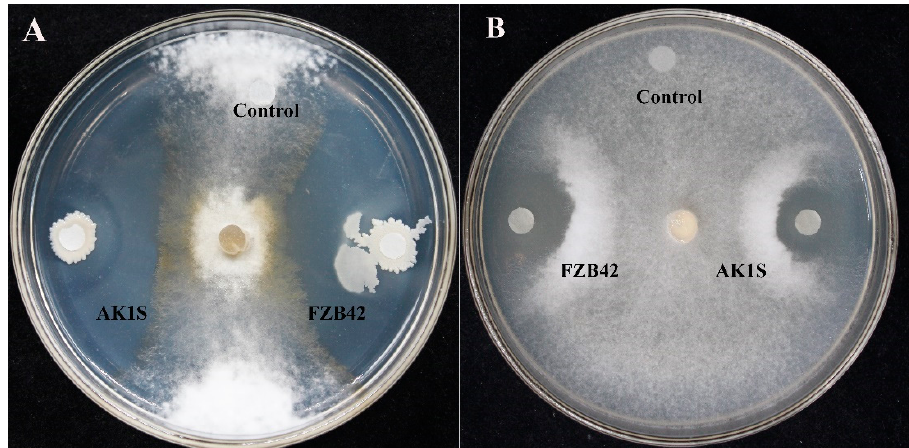
Figure 1. Antifungal activity of bacterial cultures and their crude extracts against S. sclerotiorum on Potato Dextrose Agar (PDA) medium: ( A ) direct antifungal activity of Bacillus amyloliquefaciens FZB42 wild type and AK1S mutant, and ( B ) antifungal activity of crude extracts from FZB42 and AK1S mutant.